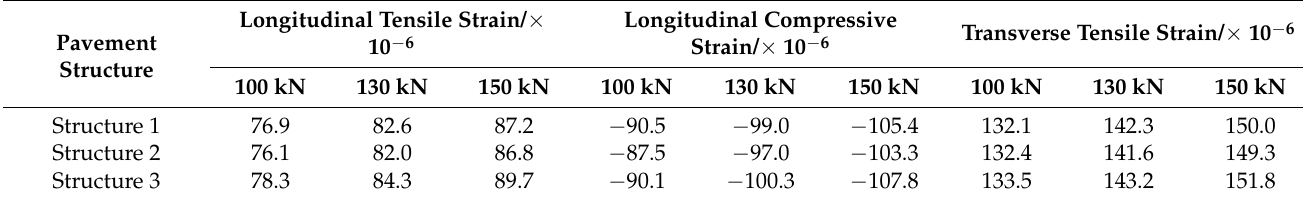
Table 3. Dynamic responses of layer substrates under different loads.